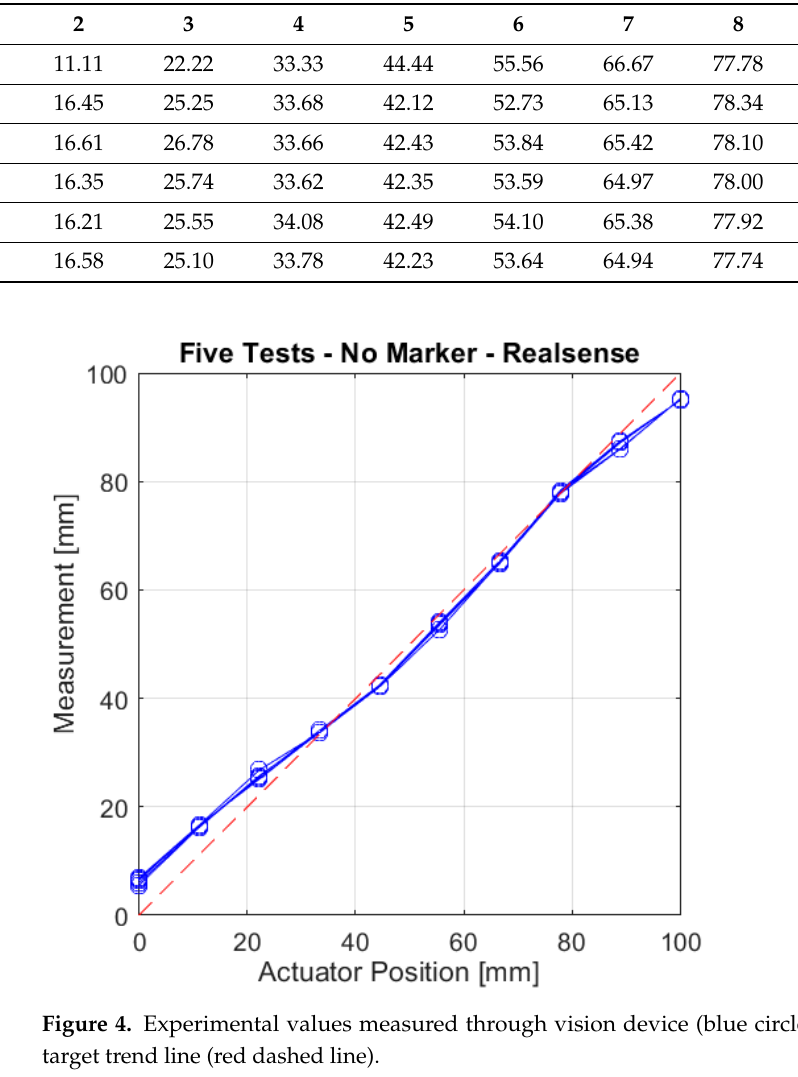
Table 1. Measurement algorithm results.